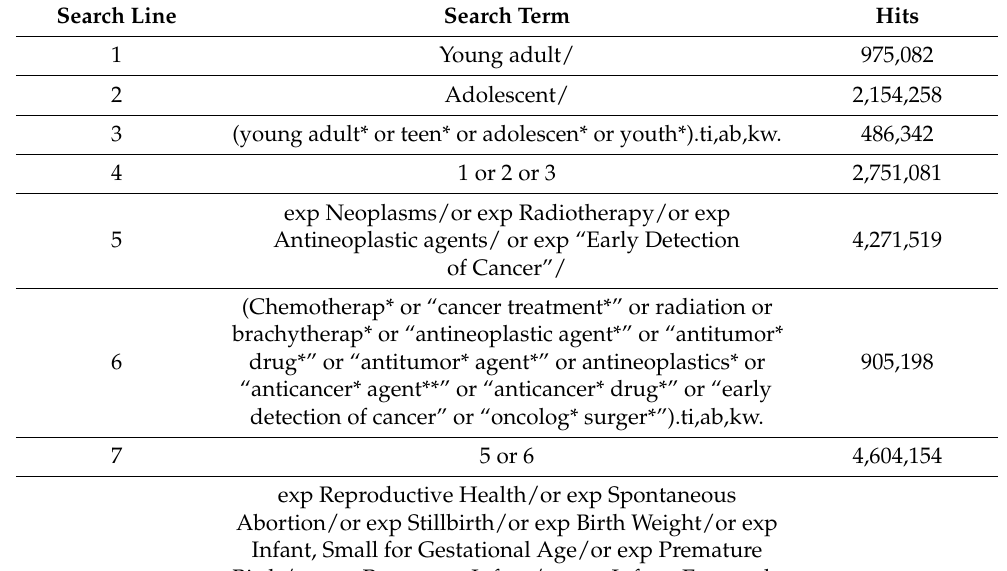
Table 2. Ovid MEDLINE(R) and Epub Ahead of Print, In-Process, In-Data-Review & Other Non- Indexed Citations, Daily and Versions(R) Search <1946 to 26 January